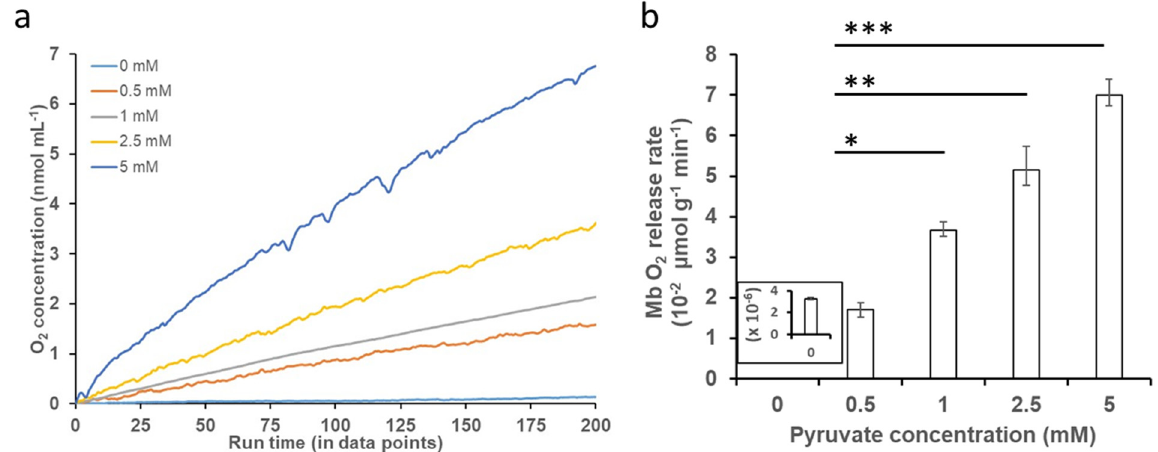
Figure 3. Effect of PYR binding to oxy-Mb and O 2 release. O 2 release kinetics were studied using an Oxytherm+ respirometer. All experiments were performed in 50 mM sodium phosphate buffer (pH 7.0, pH 6.4 and pH 6.0) containing 150 µM of oxy-Mb-enriched equine Mb preparations and varying concentrations of PYR (0.5 mM to 5 mM), using oxy-Mb alone as a zero-PYR control. ( a ) Representative graph showing O 2 release from oxy-Mb after addition of varying concentrations of PYR at pH 7.0. No release of O 2 from oxy-Mb in acidic pH (pH 6.0–pH 6.4) was detected (Figure S1). ( b ) Rate of release of O 2 from Mb against PYR concentrations at pH 7.0, calculated from the linear portion of the graphs after addition of PYR to oxy-Mb. All O 2 experiments were repeated 3 times ( n = 3). Statistical analysis was performed using one-way ANOVA. * p < 0.05, ** p < 0.01, *** p <